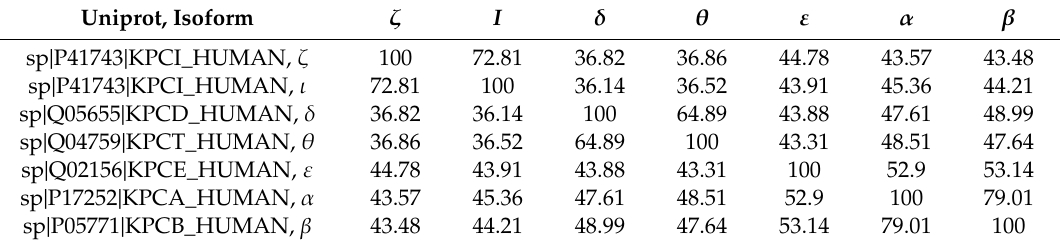
Table 1. Percent identity matrix from the sequence alignment of protein